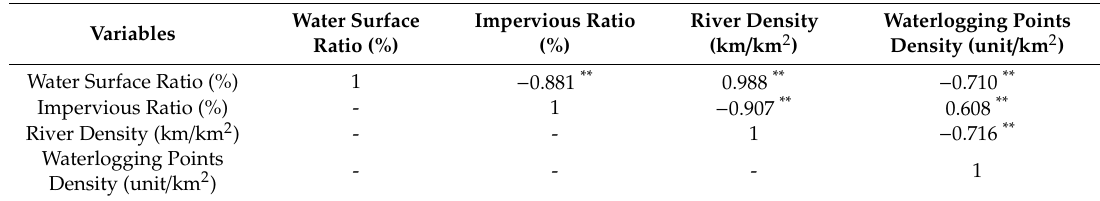
Table 1. Pearson’s correlation among the four